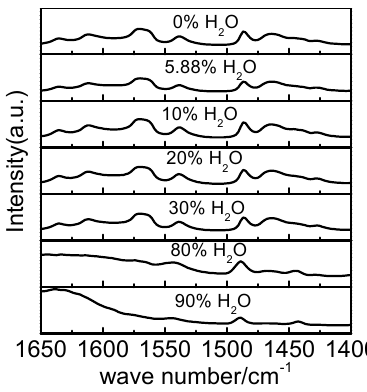
Figure 2. IR spectra of mixtures prepared from pyridine and [bmim]Fe(III)Cl 4 –H 2 O at different values for x (H 2 O).